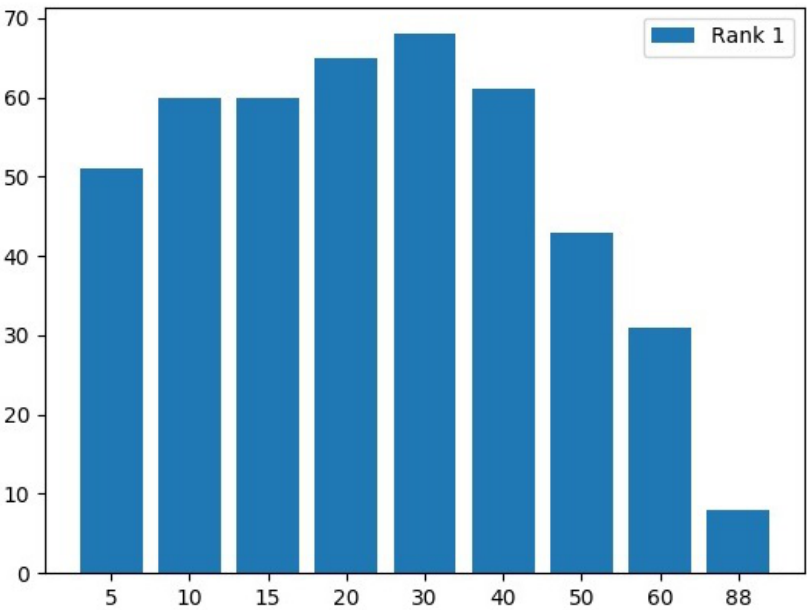
Figure 5. Histogram of occurrences of rank = 1 while varying the number of retained components of the